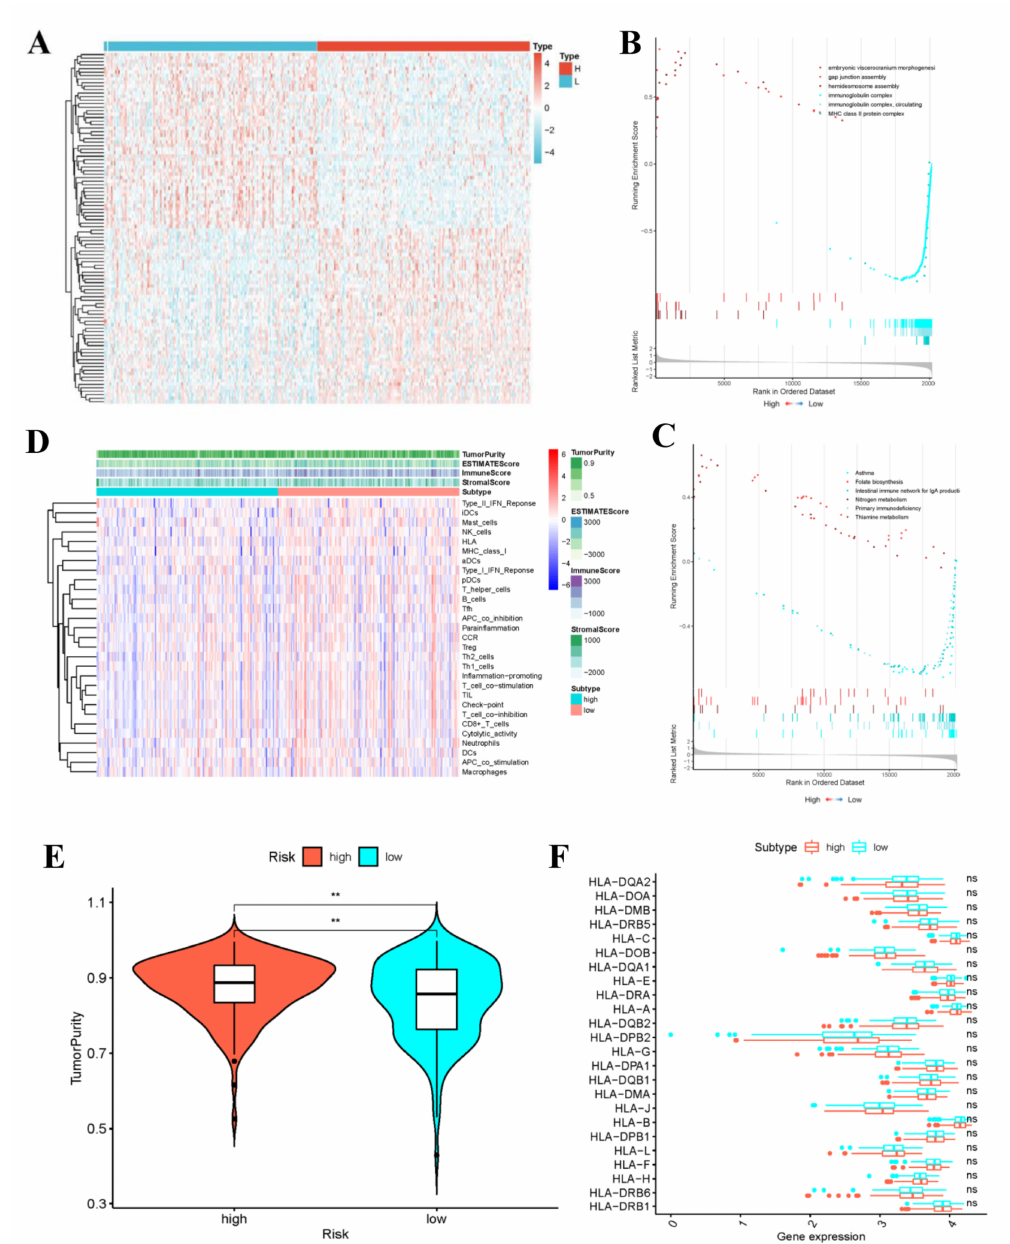
Figure 10. Gene set enrichment analysis and the low-risk and high-risk samples show different tumor purity. ( A ) Differential Analysis Heatmap. ( B ) Plot of GO enrichment results. ( C ) Plot of KEGG enrichment results. The immune status ( D ), tumor purity ( E ) and the distribution of HLA related genes (** p -value < 0.01) ( F ) of the low-risk and high-risk